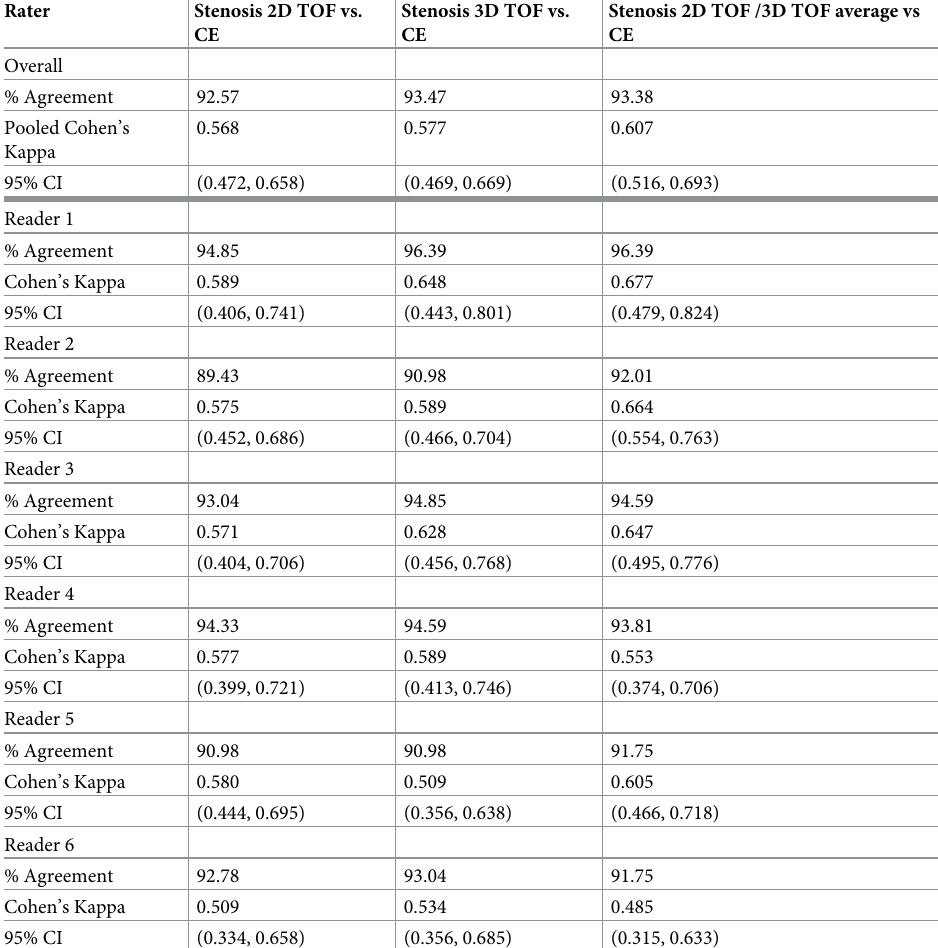
Table 4. Unenhanced vs enhanced agreement (Dichotomous stenosis rating, grades 1,2 vs 3–6).